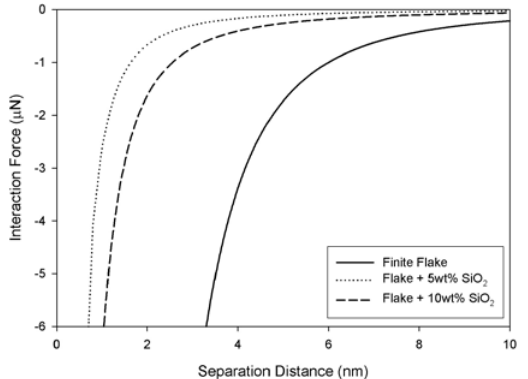
Calculated van der Waals forces with the addition of silica be- tween two flakes. A comparison of the calculated van der Waals forces for two smooth flakes is seen to be much higher than for two smooth flakes separated by silica spacer material. The Plot 1 (solid) shows the calculated van der Waals force for two smooth disks and Plot 2 (dotted) shows the calculation for two disks sep- arated by 5 wt% of 10 nm fumed silica particles. Plot 3 (dashed) shows the calculation when 10 wt% silica is added. The spacer has the same effect as increasing surface roughness, but done without having to alter the flakes themselves. The Hamaker constant of silica is also lower than that of aluminum which also contributes to a decrease in van der Waals forces.